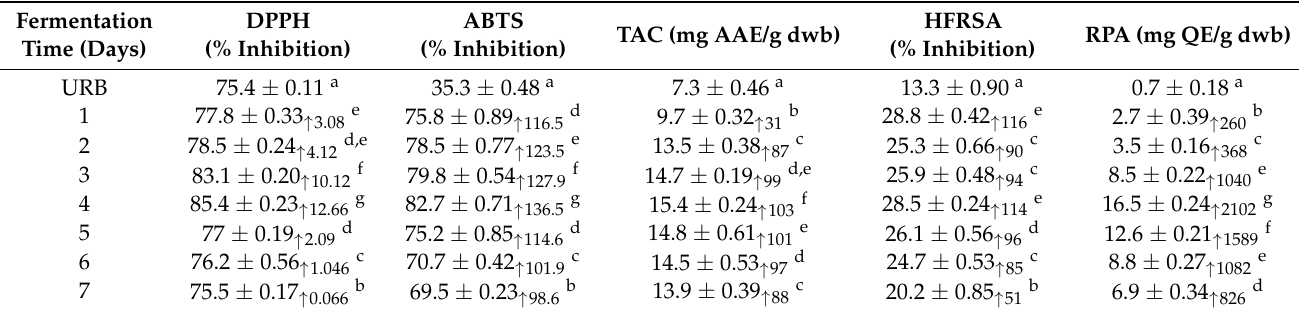
Table 4. Effect of duration of fermentation on DPPH, ABTS inhibition, total antioxidant capacity (TAC), hydroxyl free radical scavenging activity (HFRSA) and reducing power assay